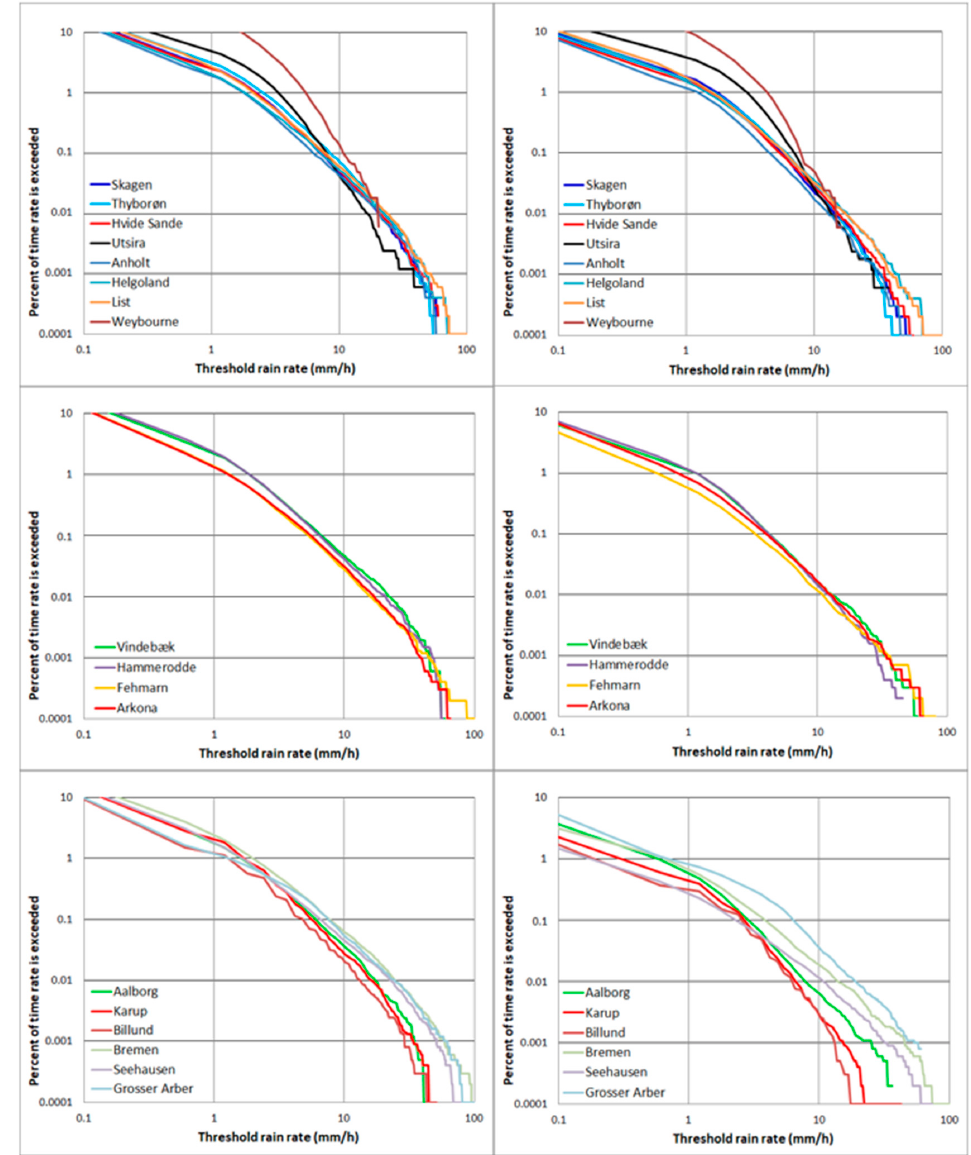
Figure 5. The graphs show the average yearly variation of percentage of time of exceedance of rain rates (in mm h − 1 ) for all wind speeds (left panels) and for wind speeds ≥ 7 m s − 1 (right panels) for the North Sea (top), Baltic Sea (middle), and inland stations (bottom).